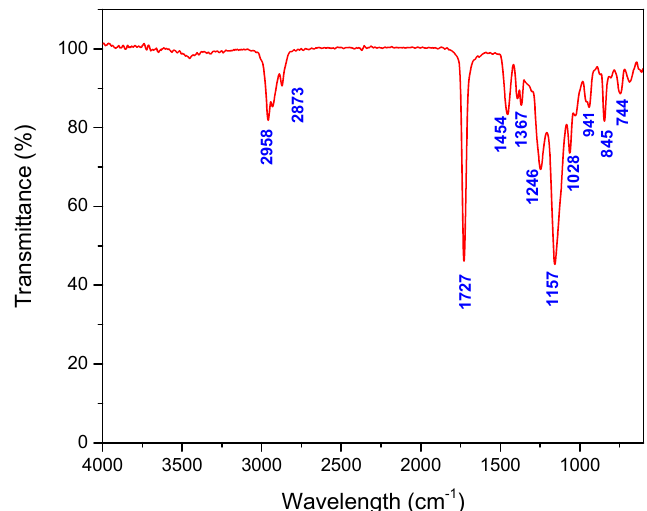
Figure 1. ATR-FTIR spectrum of the low gloss acrylic film with crosslinker AMA content 0.2 wt %.